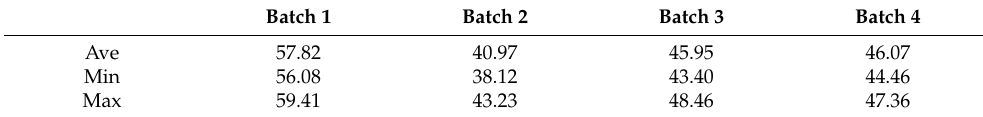
Figure 2. Hardness results: ( a ) batch 1; ( b ) batch 2; ( c ) batch 3; and ( d ) batch 4. Table 2. Hardness measurements summary